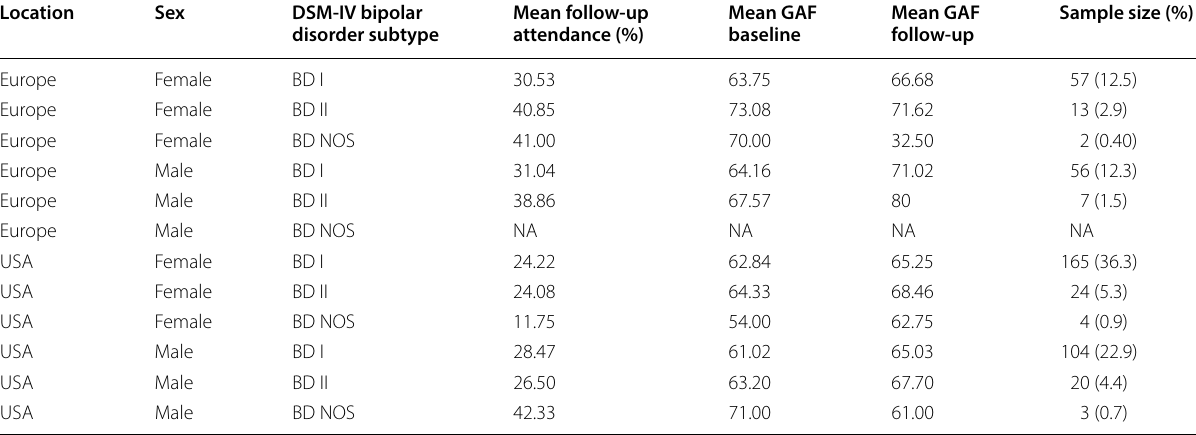
Table 2 Sample demographics, mean GAF at baseline, and follow-up by location, sex and BD subtype